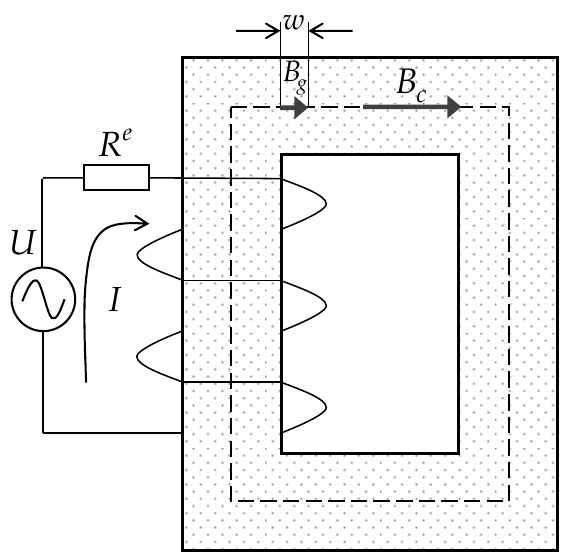
Figure 2. The electric circuit and magnetic flux flow over the core (front view).